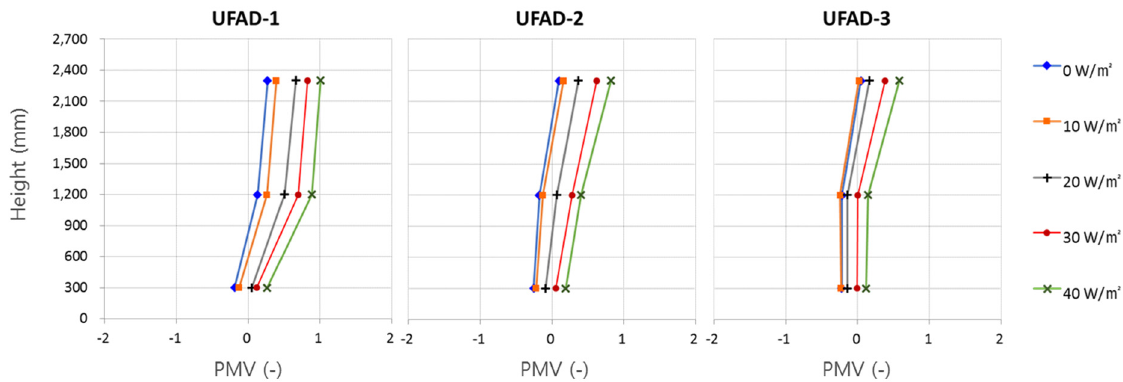
Figure 23. Vertical distribution of PMV at (X1, Y2), UFAD.